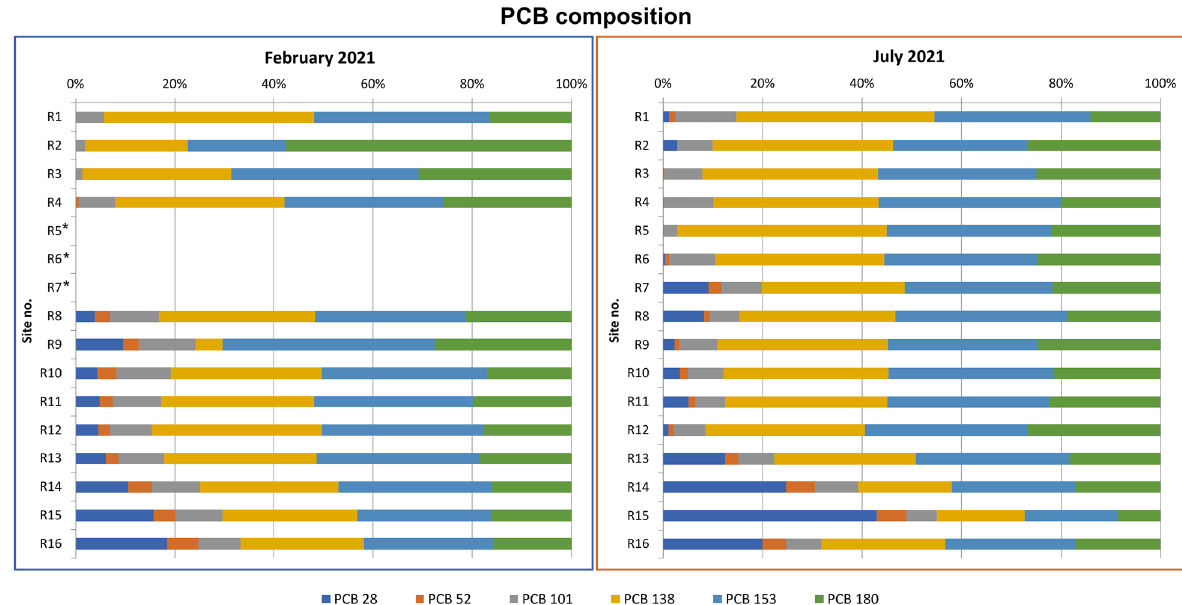
Fig. 5 Composition of the PCB mixtures divided into 6 representative congeners. Representative congeners are PCB 28, PCB 52, PCB 101, PCB 138, PCB 153, PCB 180. (*) R5 to R7 were not sampled in